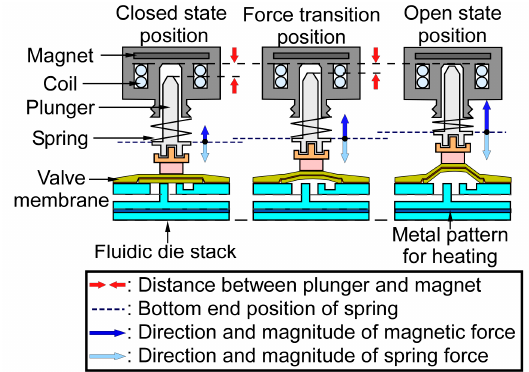
Figure 5. The relationship between the distance and the force of the solenoid actuator. The closed state position has a net force exerting downward, whereas the open state position has a net force exerting upward.